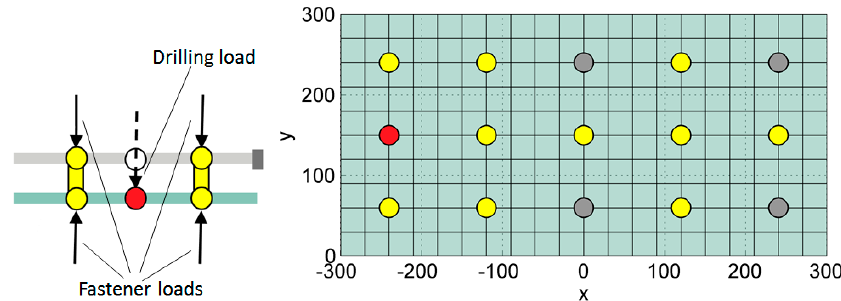
Figure 5. Location of the empty holes, installed temporary fasteners and the hole to be drilled.